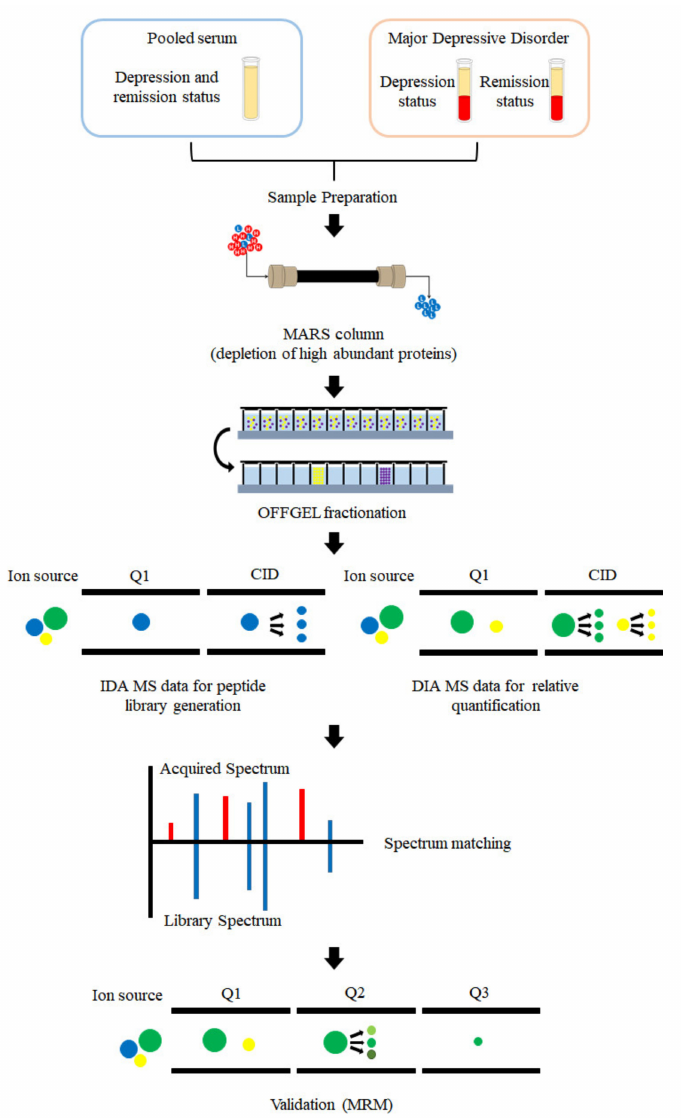
Figure 1. Experimental scheme for discovering the biomarkers for major depressive disorder (MDD). Blood was collected from patients with MDD and those in remission. Pooled serum was collected from all patients with MDD and those in remission. High abundant proteins in all samples including pooled serum were depleted using a multiple affinity removal system (MARS) LC column. Low- abundant proteins were digested with trypsin. The pooled serum was fractionated by OFFGEL electrophoresis and used to generate a peptide library by information-dependent acquisition MS analysis; each sample was analyzed in data independent acquisition (DIA)-MS mode. The DIA-MS data acquired from each sample were matched with the peptide library. For validation, multiple reaction monitoring (MRM) mode was used for absolute quantification of the selected